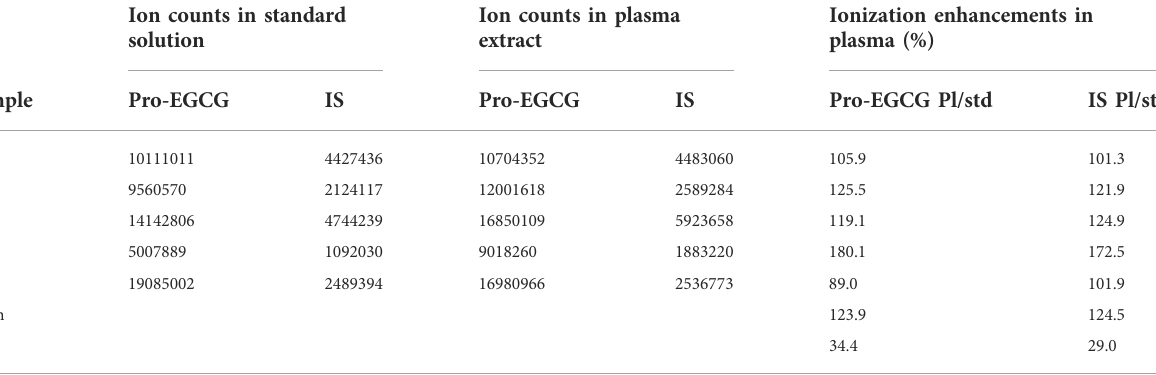
TABLE 3 Ionization enhancement of pro-EGCG and internal standard in plasma matrix. The table showed the ion counts of 2.5 μ g/mL pro-EGCG and 5 μ g/mL internal standard separately presented in the standard solutions and plasma matrices. Ion counts in standard Ion counts in plasma solution